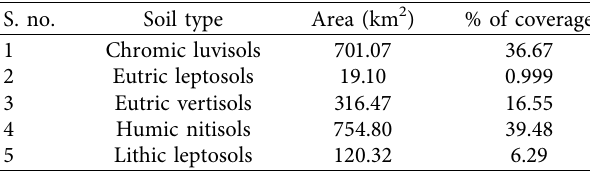
Table 2: Dominant soil types of the study